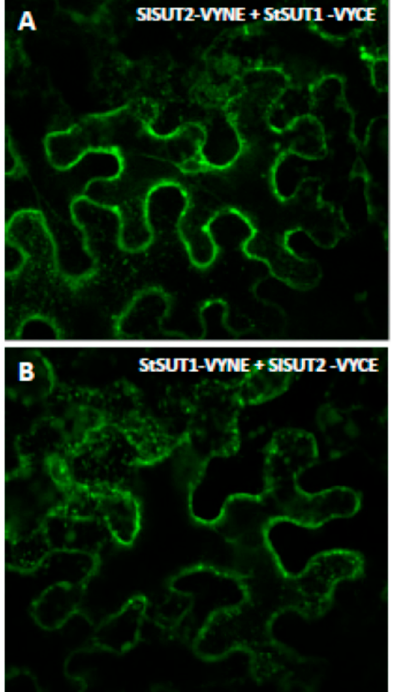
Figure 3. StSUT1 and SlSUT2 are able to form homodimers in planta ( A ). and ( B ). Confirmation of StSUT1-SlSUT2 heteromerization in planta by BiFC experiments using the vectors VYNE and VYCE (Gehl et al., 2009) in both possible combinations. Note that heterodimerization of StSUT1 and SlSUT2 increases internalization of the heteromeric complex.